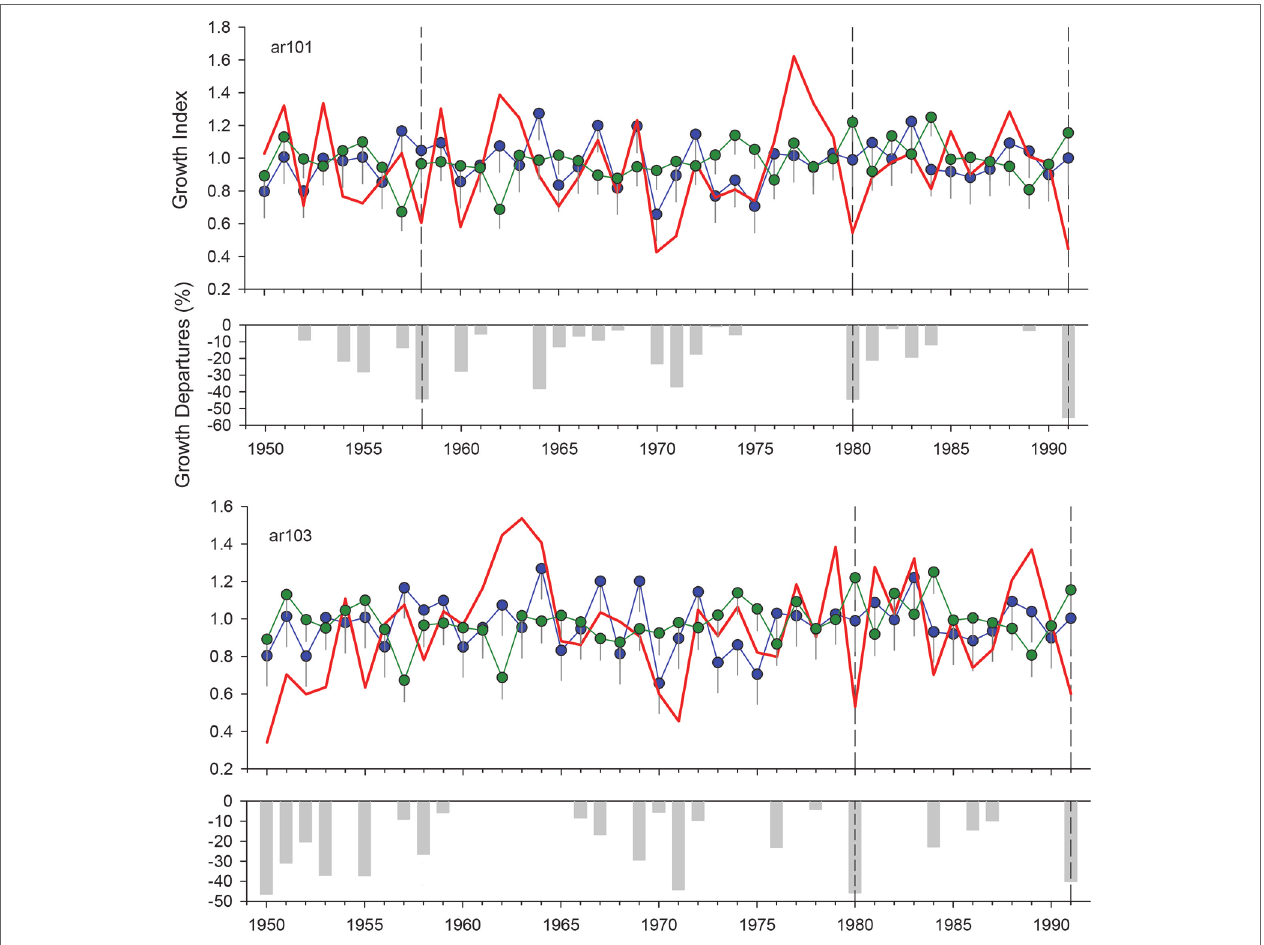
FIGURe 5 | Selection of potential N. pumilio growth reductions by spring frosts considering the local (red lines), regional (blue lines) and A. chilensis (green lines) chronology. The vertical lines indicate the standard error. The lower bar graphic indicates the growth departures (%) from the regional N. pumilio chronology. Vertical grey discontinuous lines show sharp growth reductions not present in the regional mean or the A. chilensis chronology, and with significant minimum temperatures during the leaf unfolding.